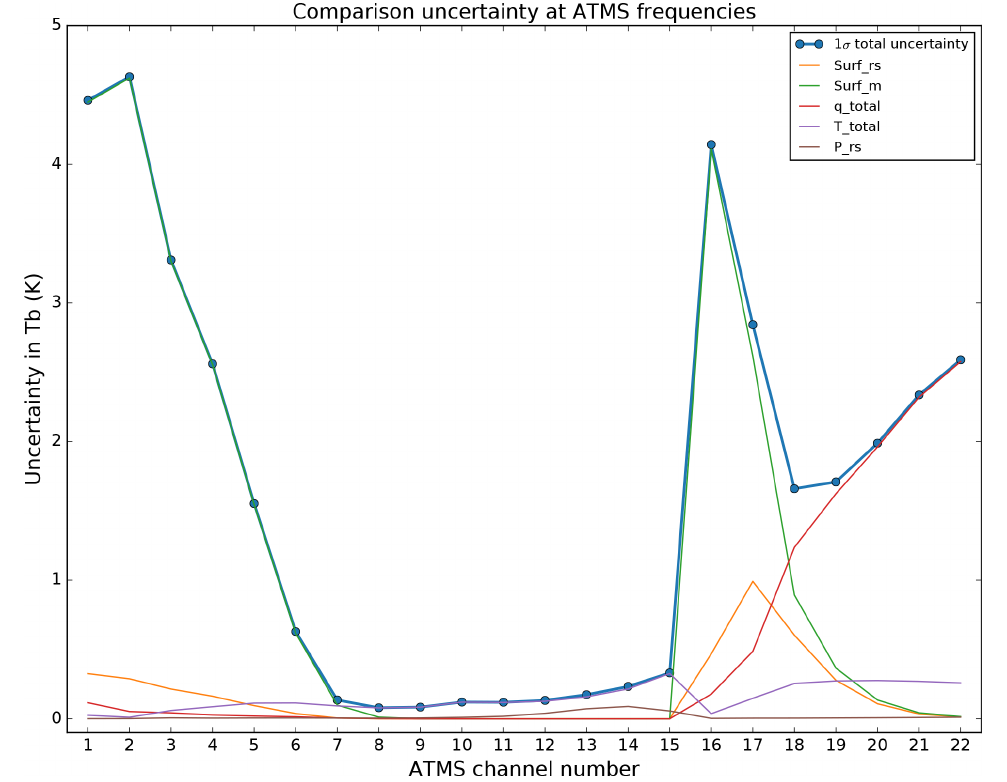
Figure 6. The 1 σ standard deviation of the total uncertainty distribution expressed as the square root of the diagonal of the mean comparison covariance S δy (blue dots) and the square root of the diagonal of the components forming S δy , namely, the GRUAN surface uncertainty (Surf_rs, orange), the model surface uncertainty (Surf_m, green), the humidity total uncertainty (q_total, red), the temperature total uncer- tainty (T_total, purple), and the GRUAN pressure uncertainty (P_rs,